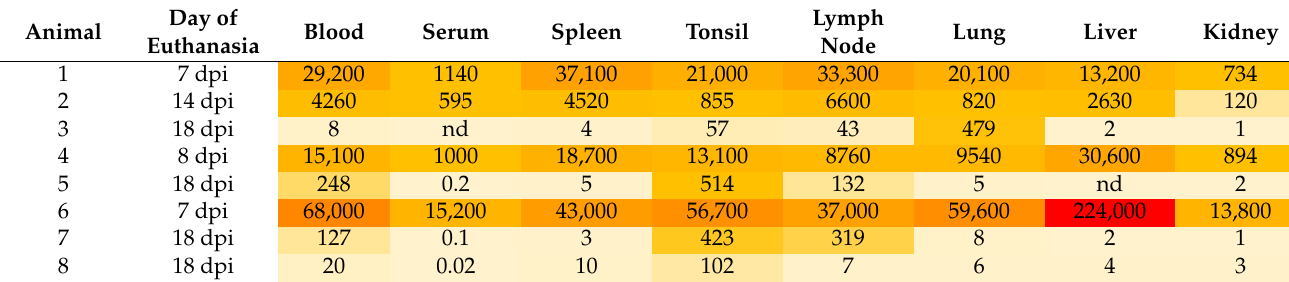
Table 4. Trial A: real-time PCR results of blood, serum, and organ samples at the day of euthanasia. Genome detection in blood, serum, and organs are presented as genome copies per reaction (5 µ L). The color intensity indicates the relative level of viral loads (darker colors indicating higher loads, from light yellow to deep red). nd: not detected. Day of Animal